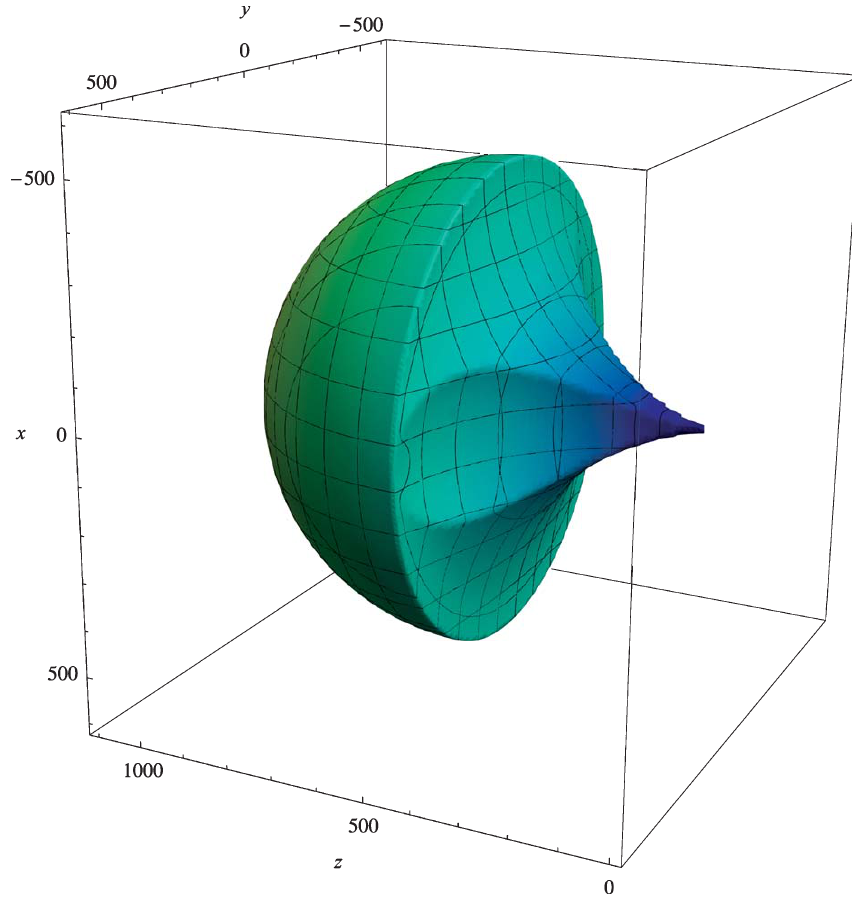
Fig. 15. 3D representation of the workspace of point M (example with ϑ 1 = 0 rad, ϑ 2 = π/ 2 and ϑ 3 = − π/ 2